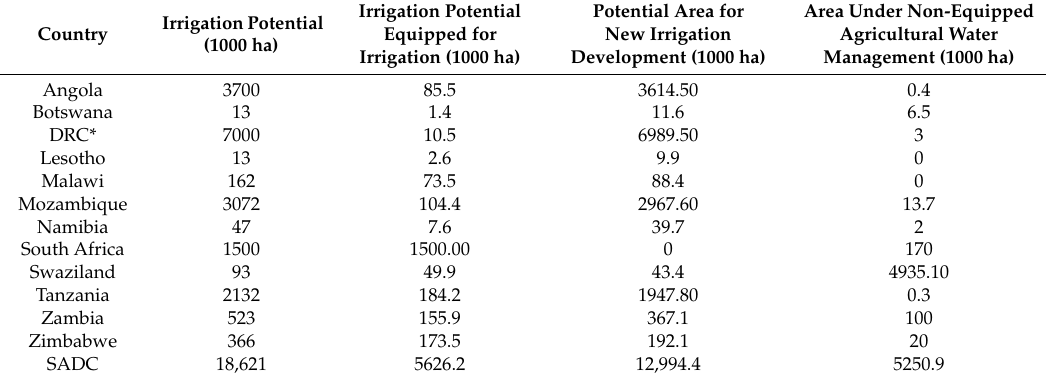
Table 1. Area of irrigation potential and area under water management in southern African countries. IrrigationPotential Country (1000 ha)